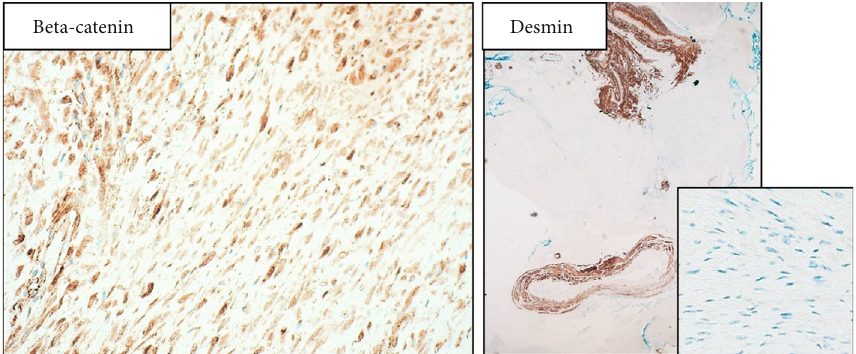
Figure 4: The neoplastic cells expressed positive aberrant nuclear staining for beta-catenin and were negative for